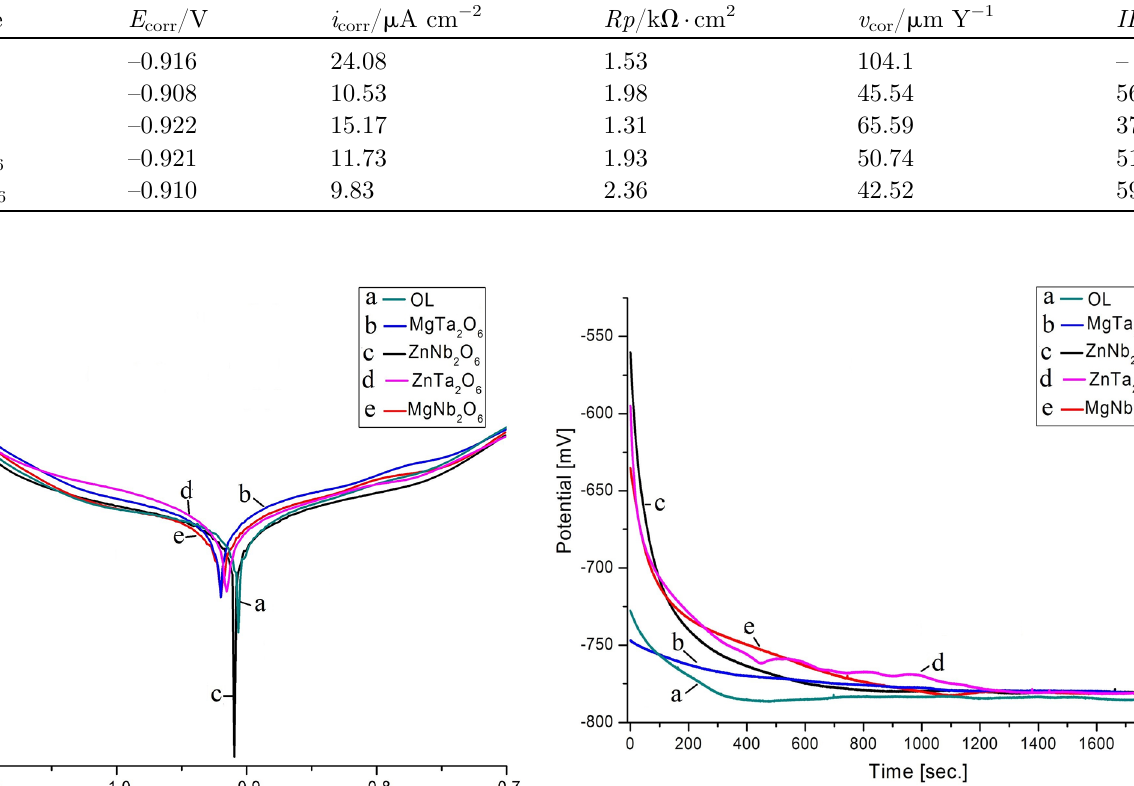
Table 3. Tafel parameters of the investigated electrodes after 30 min immersion in 0.5 M Na Electrode